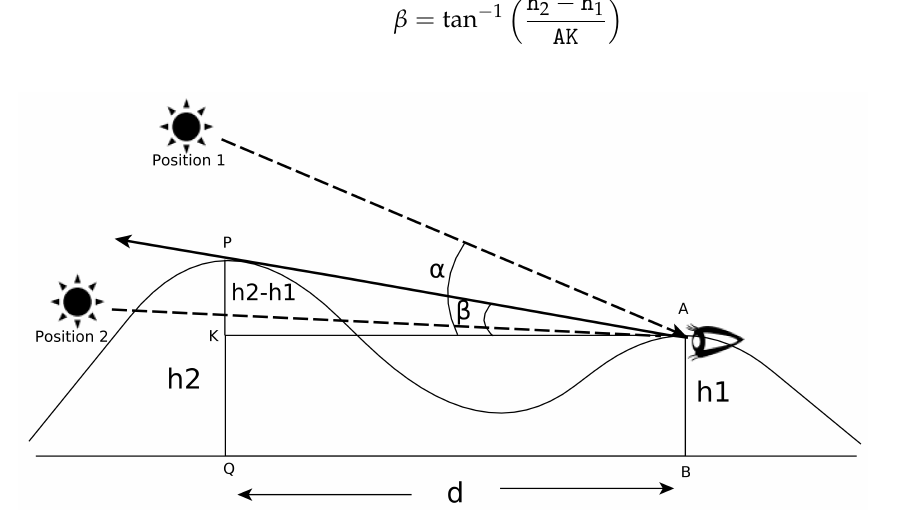
Figure 4. Shadow Calculation on Bumped